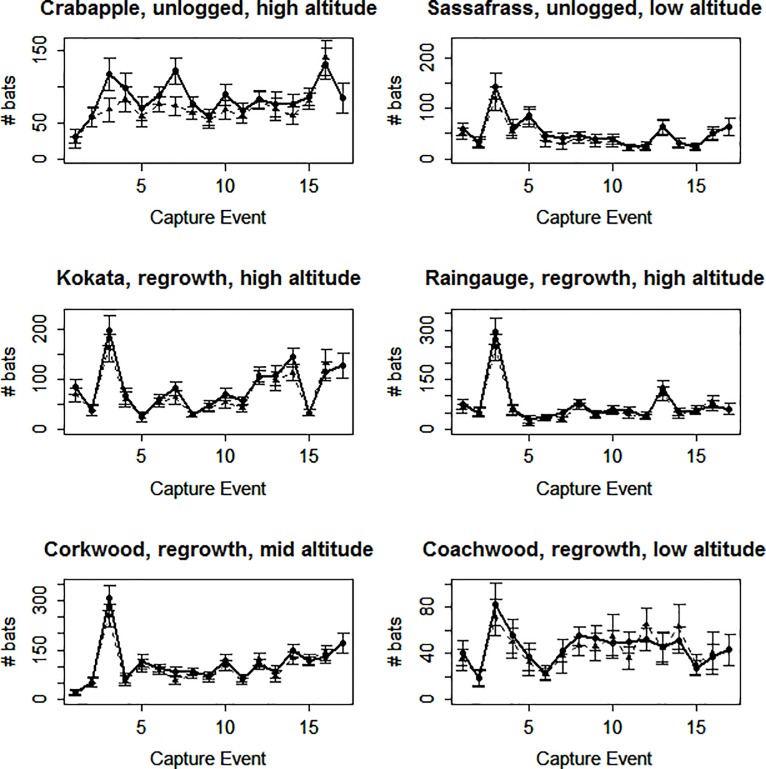
Plots of estimated abundance (●) and number of residents (▲) over all four species per site with respect to capture event, numbered as in Fig 3.